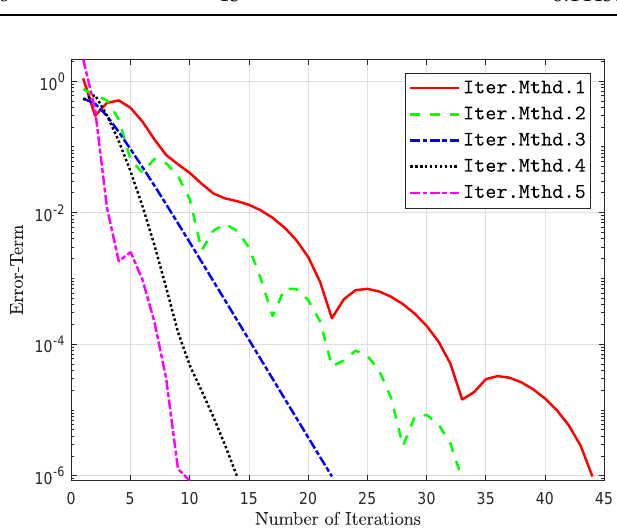
Figure 9. All techniques are computationally examined while s 0 = ( 1, − 1,2,0,3 ) T